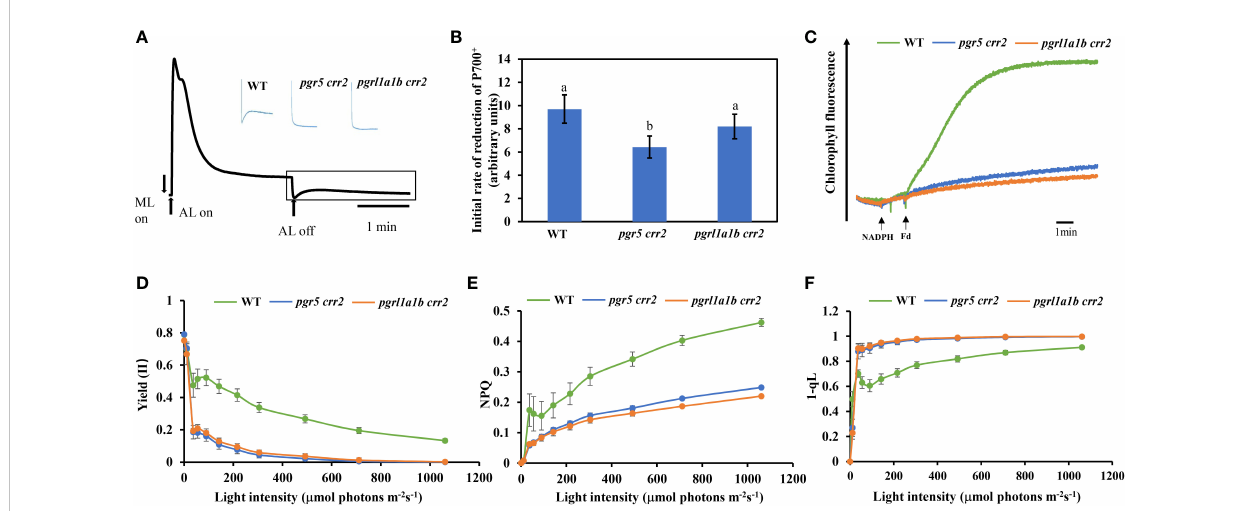
FIGURE 2 Comparison of CET activity and photosynthetic parameters among CET mutants and wild type (WT). (A) Typical kinetics of chlorophyll fl uorescence change in WT. Vertical bars indicate the timing of on or off points of white actinic light (AL; 120 m mol photons m − 2 s − 1 ). The part in the rectangle shows the transient increase in chlorophyll fl uorescence, which re fl ects NDH activity. Insets are the traces of different mutants and WT from the boxed area. (B) The initial reduction rate of P700 + after far-red light. (C) Increase in chlorophyll fl uorescence induced by the addition of NADPH (0.25 mM) and Fd (5 mM) to osmotically ruptured chloroplasts (20 m g Chl ml − 1 ) under the illumination of weak measuring light (1.0 m mol photons m − 2 s − 1 ) in the WT and CET mutants. (D) Light curve of the quantum yield of the PSII photochemistry [Yield (II)]. (E) Light curve of non-photochemical quenching (NPQ). (F) Light curve of redox state of Q A calculated as 1 – qL. Values are means ± SE of fi ve independent measurements. Signi fi cant differences ( p < 0.05) are labeled with different letters on the column. The least difference method ( LSD method) was used for the difference signi fi cance test and multiple ratio comparison. Plants used for these experiments were cultured at a light intensity of 60 m mol m − 2 s − 1 at 22°C for 10